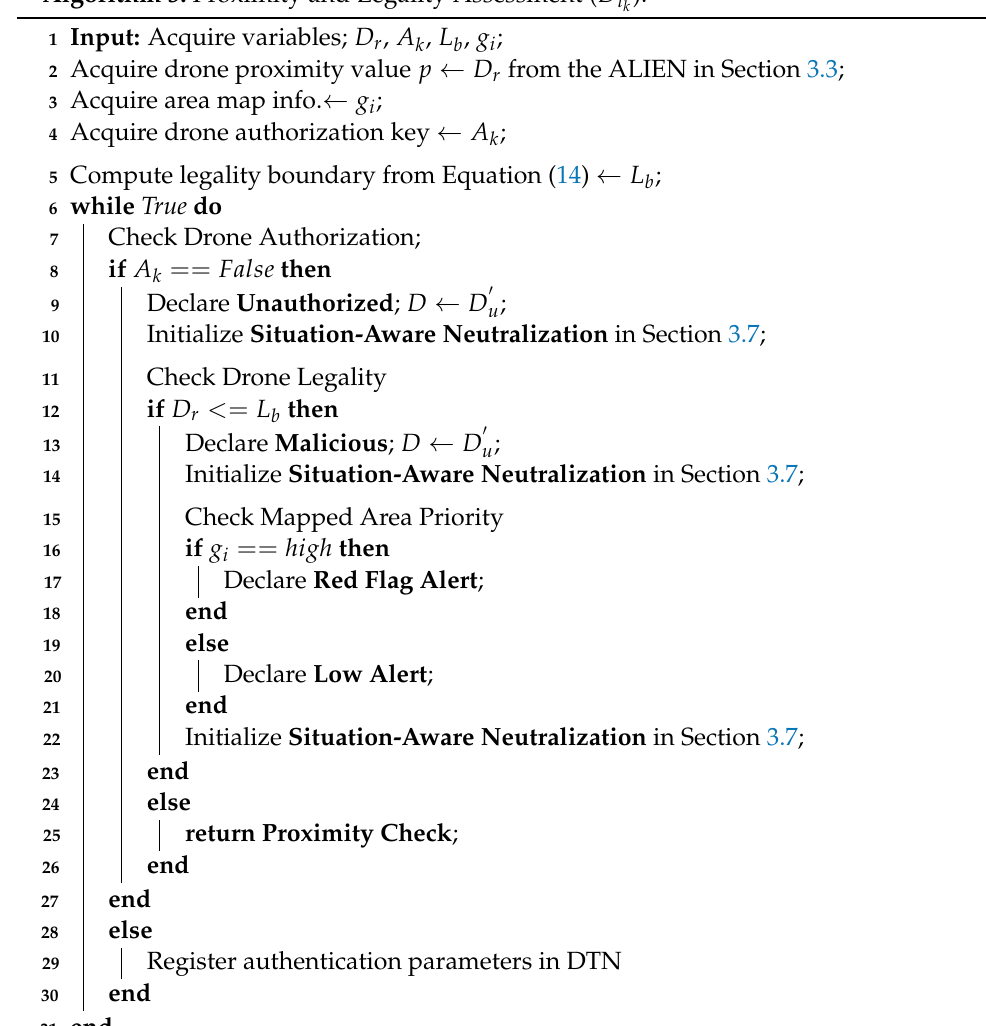
Algorithm 3: Proximity and Legality Assessment ( D l